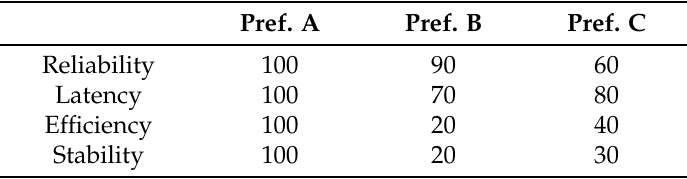
Table 9. Three preference models used for weighting